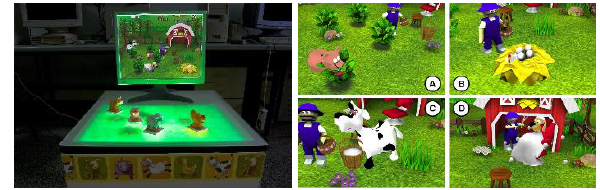
Figure 2. Farm game. Different goals of the farm game: a/ collecting strawberries. b/ laying eggs. c/ giving milk. d/ giving wool.